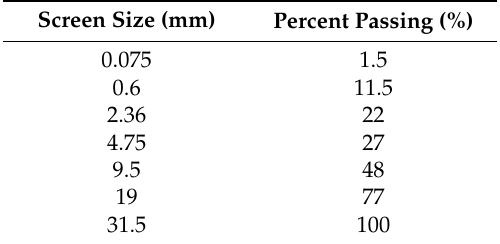
Table 4. Percent passing of aggregates.